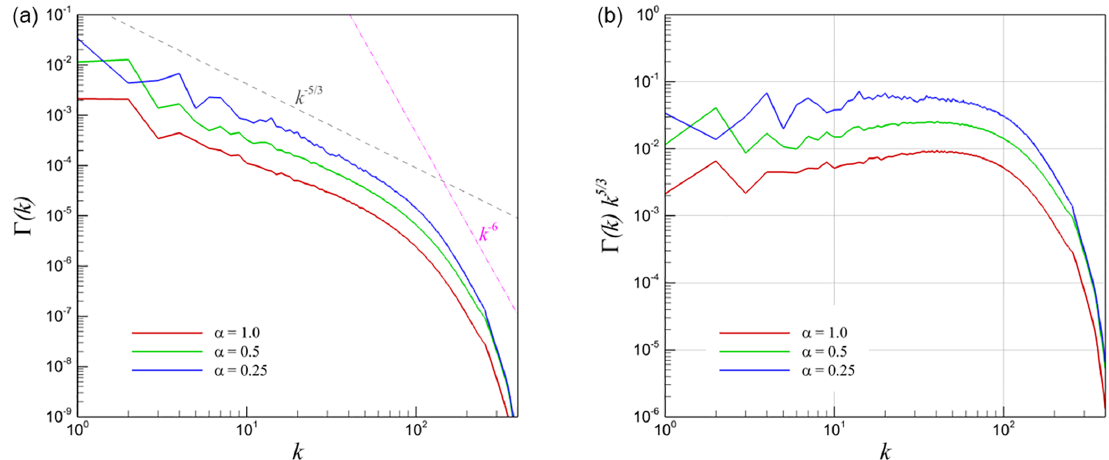
Figure 17. Spherical-averaged density power spectra for 3-D KHI turbulence (a) and its compensated form (b)